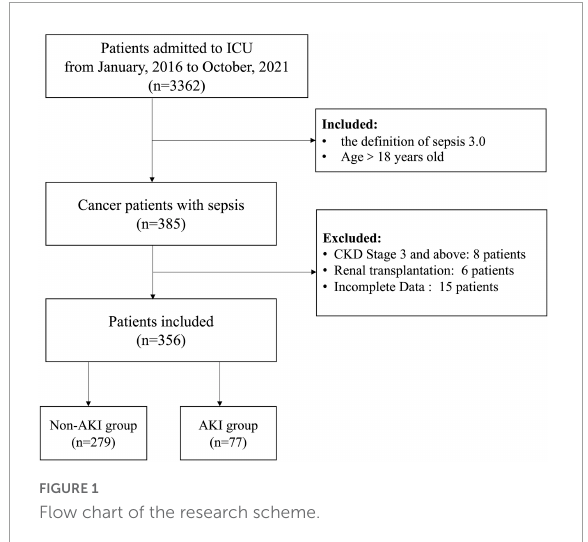
FIGURE1 Flow chart of the research scheme.